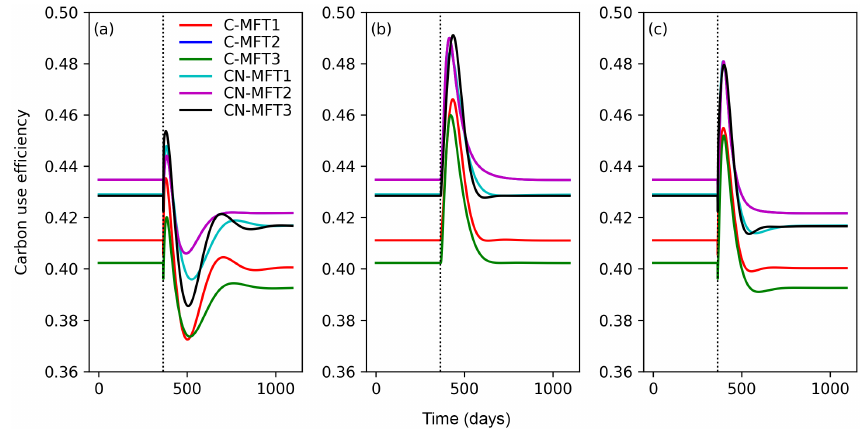
Figure 8. Temporal evolution of carbon use efficiencies (defined as ratio of carbon allocated to microbial growth to the sum of those allocated to growth and respiration) when temperature undergoes a stepwise increase of 5K (a) , when FOM input doubles (b) and when both forcings are changed (c) , for the six variants of the ORCHIMIC model. The curve for C-MFT2 overlapped with that of CN-MFT2. The vertical black dotted line shows the time when the change of temperature and/or input was